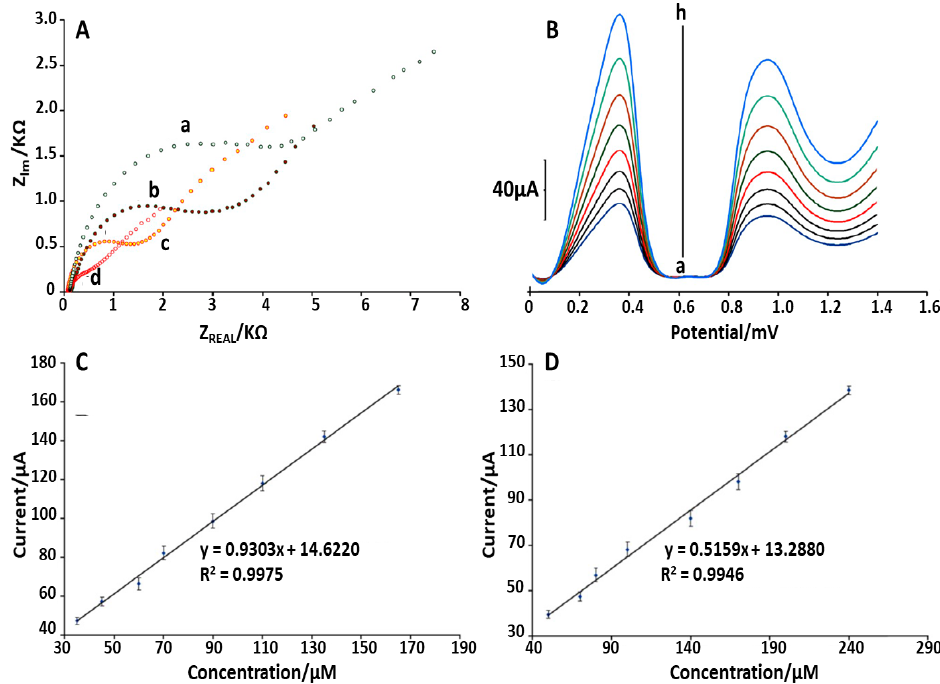
Figure 6. ( A ): Nyquist diagrams of (a) CPE, (b) FeNi 3 /rGO/CPE, (c) HMPF 6 /CPE and (d) FeNi 3 /rGO/HMPF 6 /CPE in 1.0 mM [Fe(CN) 6 ] 3 − ,4 − . ( B ): SW voltammograms of solution containing TBHQ and FA at the FeNi 3 /rGO/HMPF 6 /CPE; (a) 35.0 + 50.0; (b) 45.0 + 70.0; (c) 60.0 + 80.0; (d) 70.0 + 100.0; (e) 90.0 + 140.0; (f) 110.0 + 170.0; (g) 135.0 + 200.0 and (h) 165.0 + 240.0 μ M. ( C ): The Ipa vs. TBHQ concentration obtained from SW voltammograms. ( D ): The Ipa vs. folic acid concentration obtained from SW voltammograms [54].